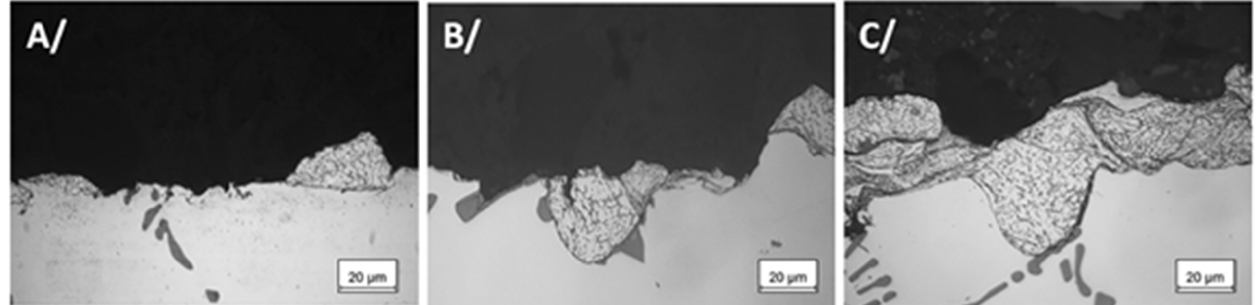
Figure 14. Fracture morphology of the cold-spray coating–substrate interface under different surface conditions. ( A ) GB sandblasting, ( B ) LST1, and ( C ) LST2 [86].